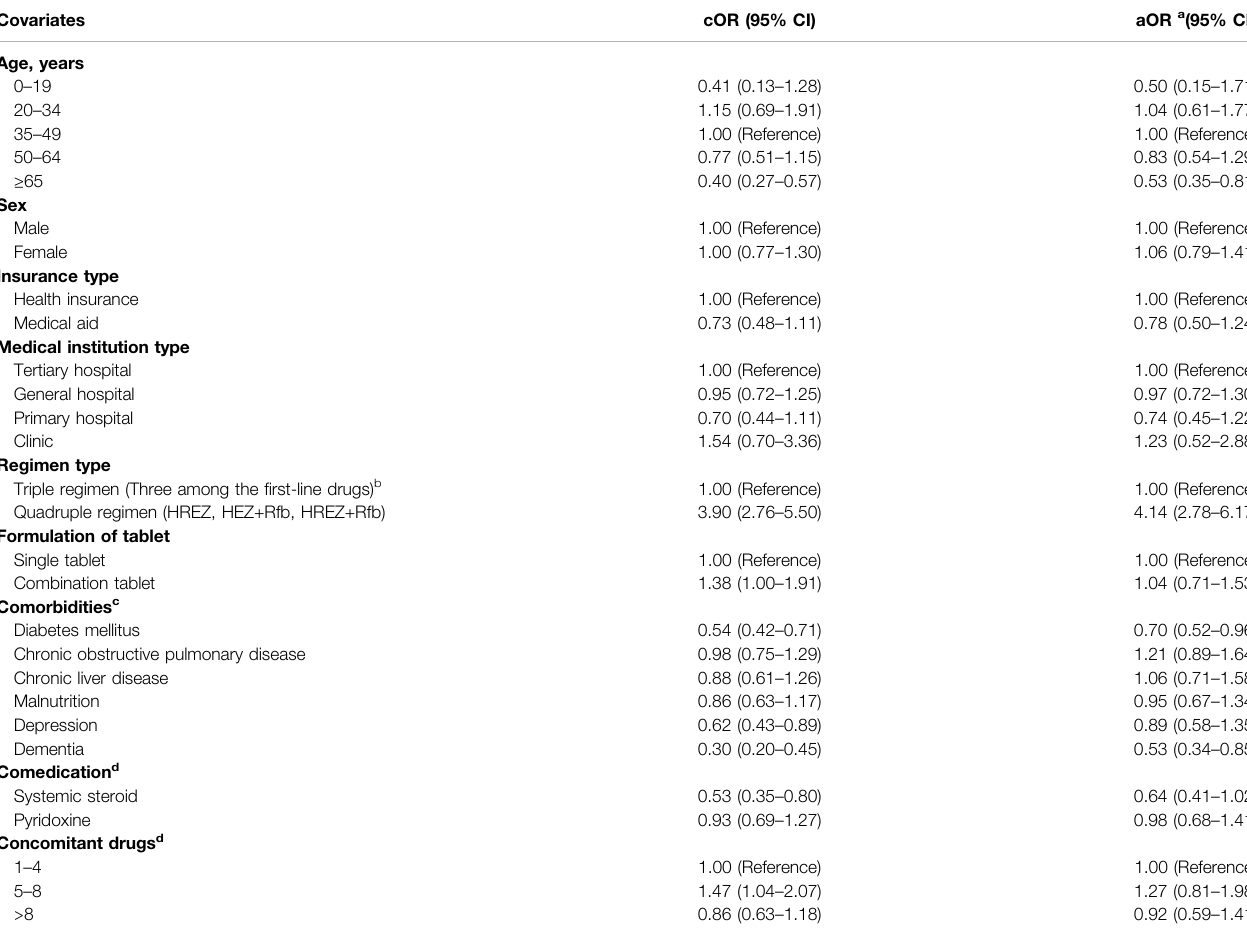
TABLE 2 | Logistic regression analysis on the association between population characteristics and adherence to the tuberculosis drugs in 2017 – 2018.